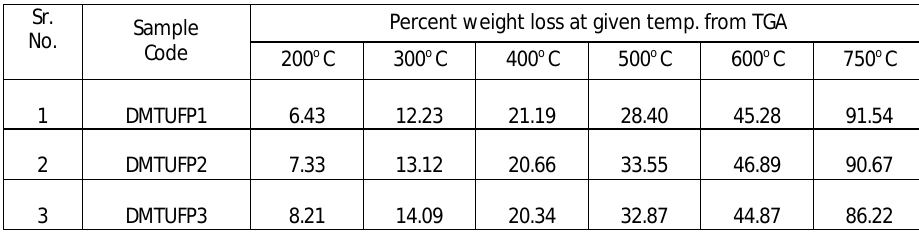
Percent weight loss at given temp. from TGA Sr.